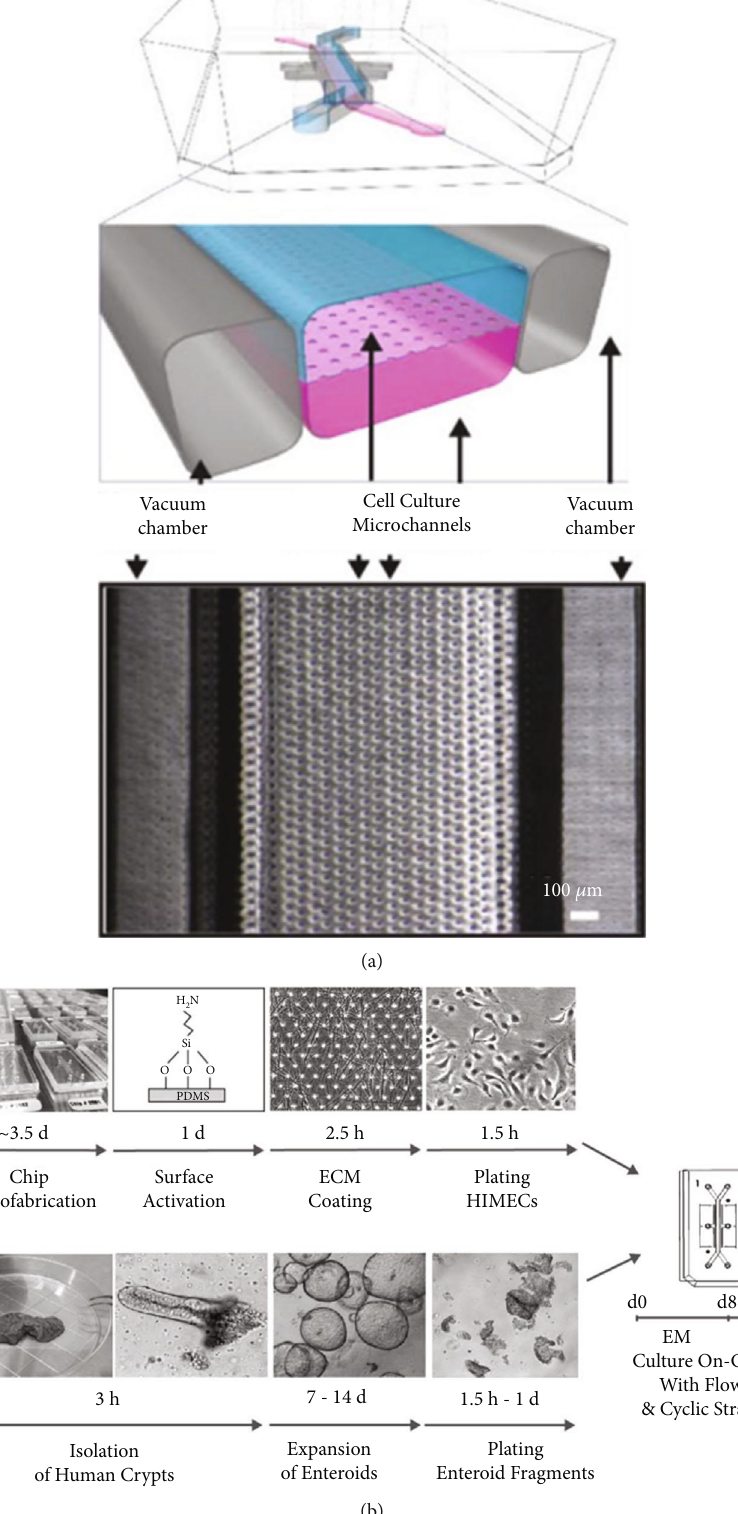
Figure 14: Fabrication of the primary human intestine chip. (a) A schematic microdevice showing the upper epithelium (blue), the lower microvascular cells (pink), and the porous membrane in-between. The di ff erent micro fl uidic channels and some components are shown. (b) Schematic representation of the procedure involved in the establishment of micro fl uidic cocultures (epithelium and endothelium). Reproduced (or adapted) with permission [87], ©2018,